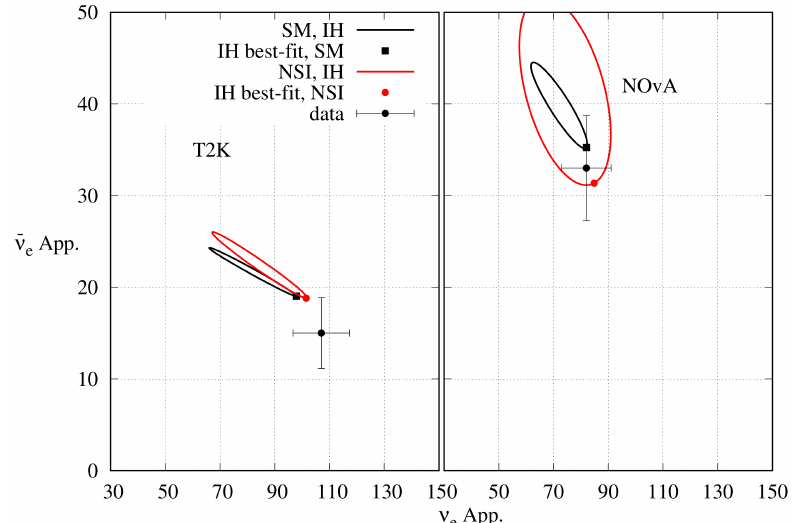
Figure 14. Bi-event plot for T2K (NO ν A) in the left ( right ) panel. The upper ( lower ) panel is for NH (IH). To generate the ellipses, δ CP has been varied in the range [ − 180 ◦ : 180 ◦ ] while keeping all other parameters fixed. Among the NSI parameters, only the effect of (cid:101) e µ has been considered. The black (red) ellipses represent the SM (NSI) case with the best-fit points indicated by a black square (red circle). The ellipses and best-fit points have been determined by fitting the combined data from NO ν A and T2K. The black circle with error bars represent the experimental data.